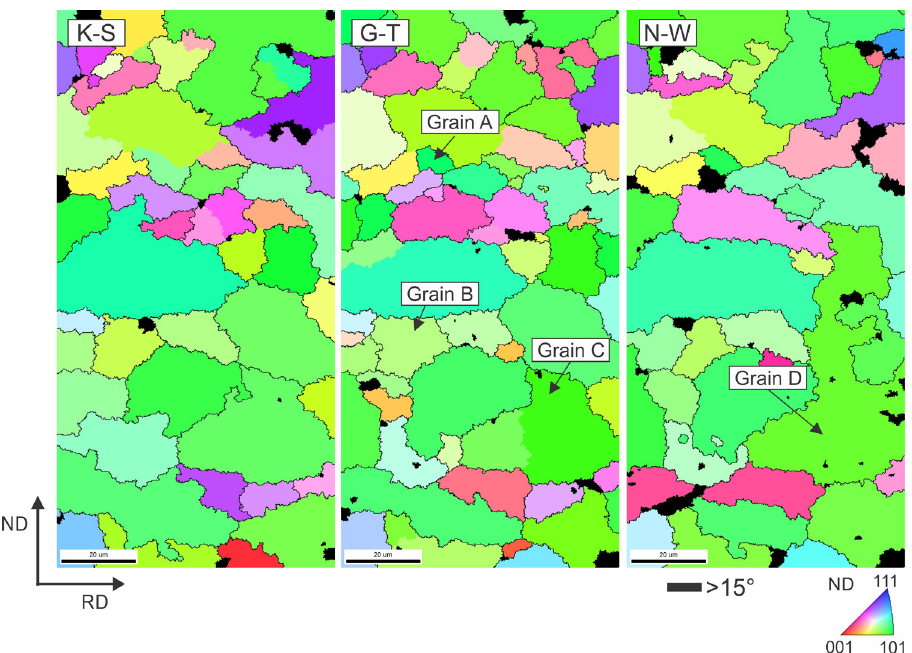
Figure 3. Sample after air-quenching treatment: reconstructed prior austenite grains for K-S, G-T and N-W ORs selected in